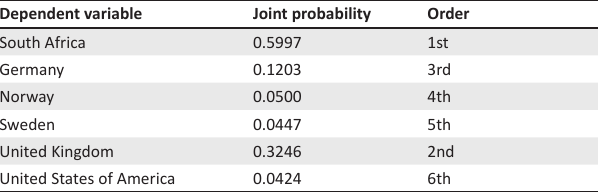
TABLE 8: Block exogeneity Wald test. Dependent